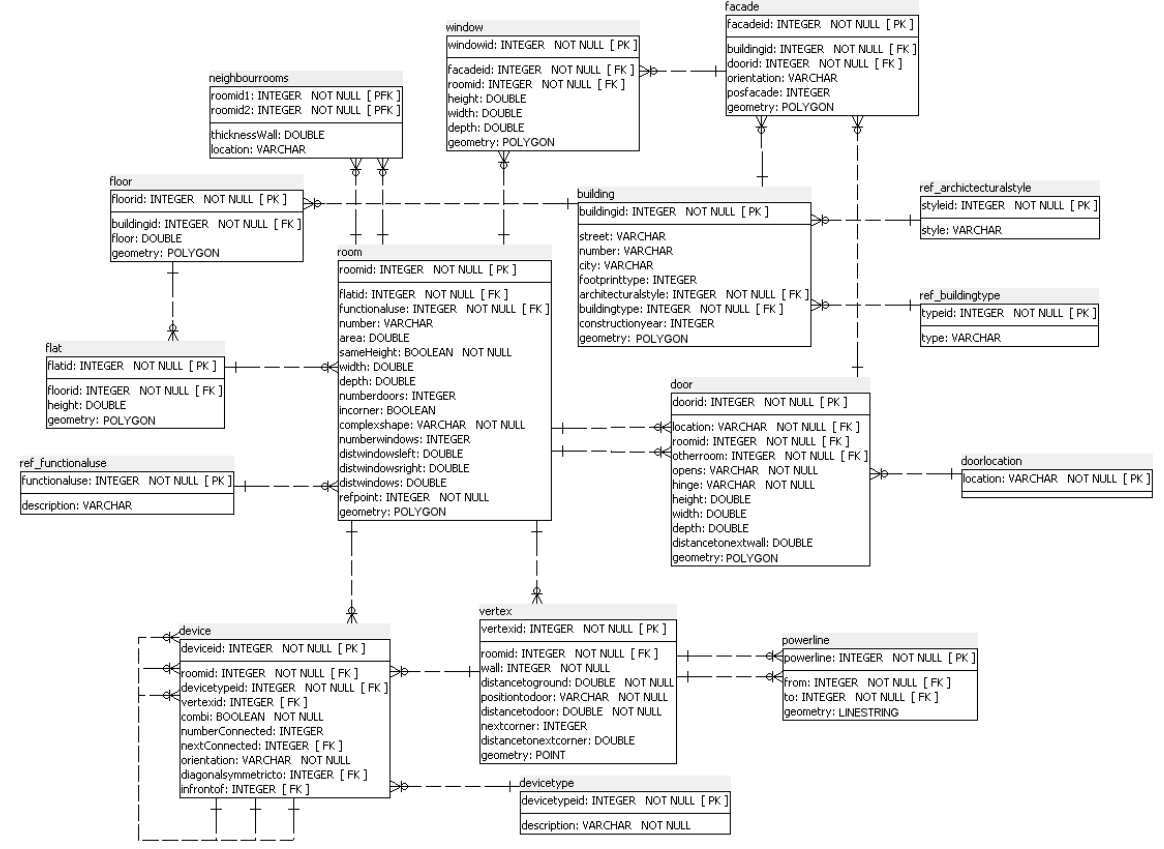
Figure 8: Excerpt from the relational database schema. Spatial objects, e.g. power line, reveal location and shape parameters. The database is used for training and evaluation.